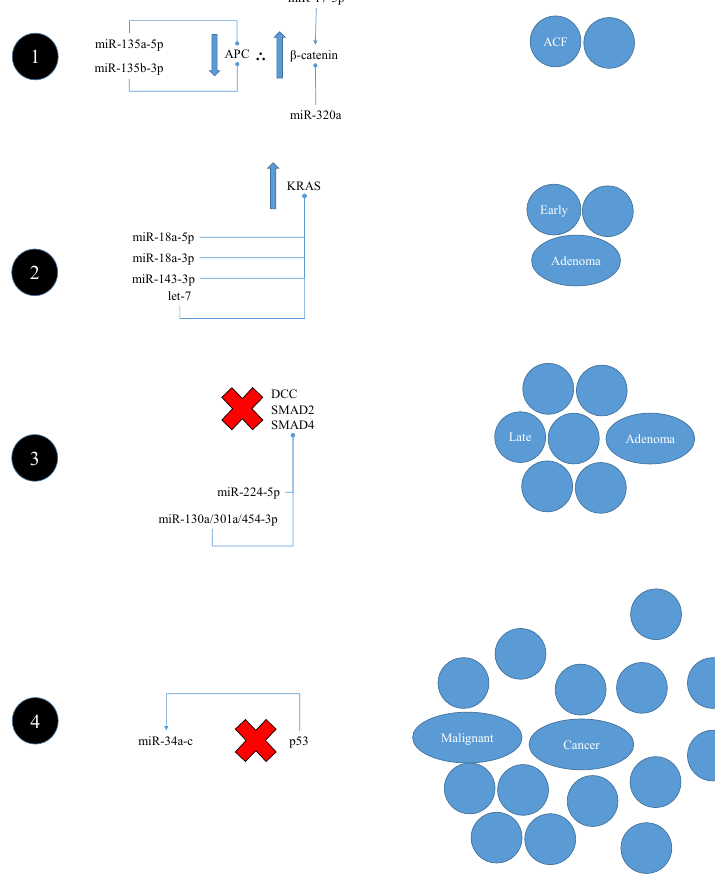
Figure 8. An illustration of the classic Vogelstein model of colorectal carcinogenesis and the reported potential interactions of miRNAs with each stage. (1) A reduction in APC activity derepresses β -catenin, which promotes cell proliferation and stem cell renewal. (2) Increased KRAS activity further promotes proliferation and the formation of an early adenoma. (3) The tumour suppressor genes DCC, SMAD2, and SMAD4 are lost, resulting in progression to a late adenoma. (4) The loss of p53 facilitates the eventual progression of the late adenoma to a malignant cancer.